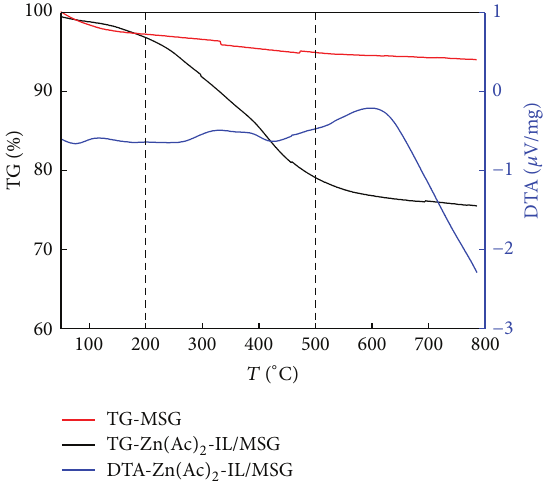
Figure 3: TG-DTA of Zn(Ac) 2 -IL/MSG and MSG.